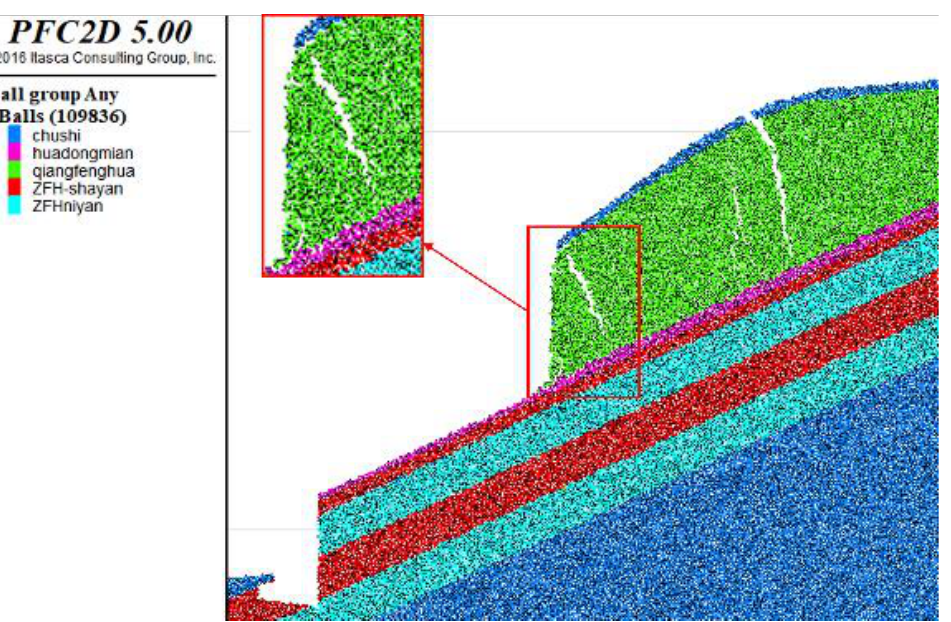
Figure 8. Displacement diagram in the early stage of slope collapse.